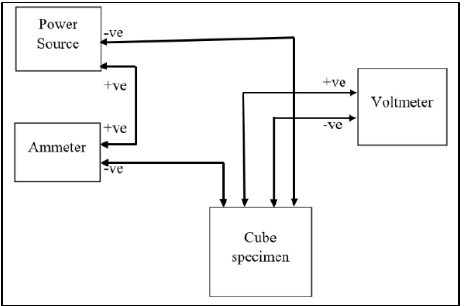
Figure 5. The four-probe method ’ s circuit diagram.